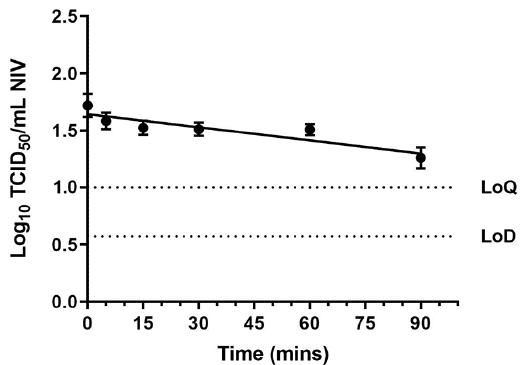
Figure 1. Survival of NiV in a small particle aerosol over time. NiV was aerosolised in TCM and held in a Goldberg Drum at a medium relative humidity (50–60%). Impinger samples were taken at set time points and enumerated by TCID 50 assay in triplicate. Three separate aerosol experiments were performed. Counts were adjusted for the dilution effect of sampling. The mean adjusted count of virus ± SEM and a best fit line from all of the runs are plotted. The limit of detection (LoD) and the limit of quantification (LoQ) of the TCID 50 assays are shown as dotted